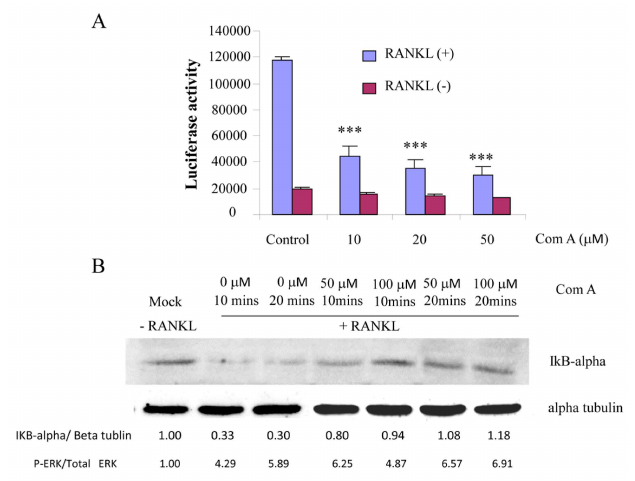
Figure 5. Compound A suppresses RANKL-induced NF- κ B activation, and reduces I κ B- α degradation. ( A ) RAW264.7 cells stably transfected with the 3kB-Luc-SV40 reporter gene were pre-treated with varying doses of compound A for 1 h followed by RANKL (100 ng/mL) stimulation. Luciferase activity in the lysates was determined after 8 h of RANKL stimulation. Each bar represents the mean ˘ SE from triplicate wells (*** p < 0.001 compared to the control, n = 3); ( B ) RAW264.7 cells were pre-treated with compound A for 1 h prior to RANKL (100 ng/mL) stimulation for 0, 10, and 20 min. Proteins extracted from whole cells were separated and transferred onto nitrocellulose membranes, which were then blocked and probed with antibodies to I κ B- α and α -tubulin. Bands were visualized by ECL and semi-quantified by densitometry. Results shown are a representation of one of three experiments performed. The levels of I κ B- α proteins are shown as a ratio to α -tubulin.